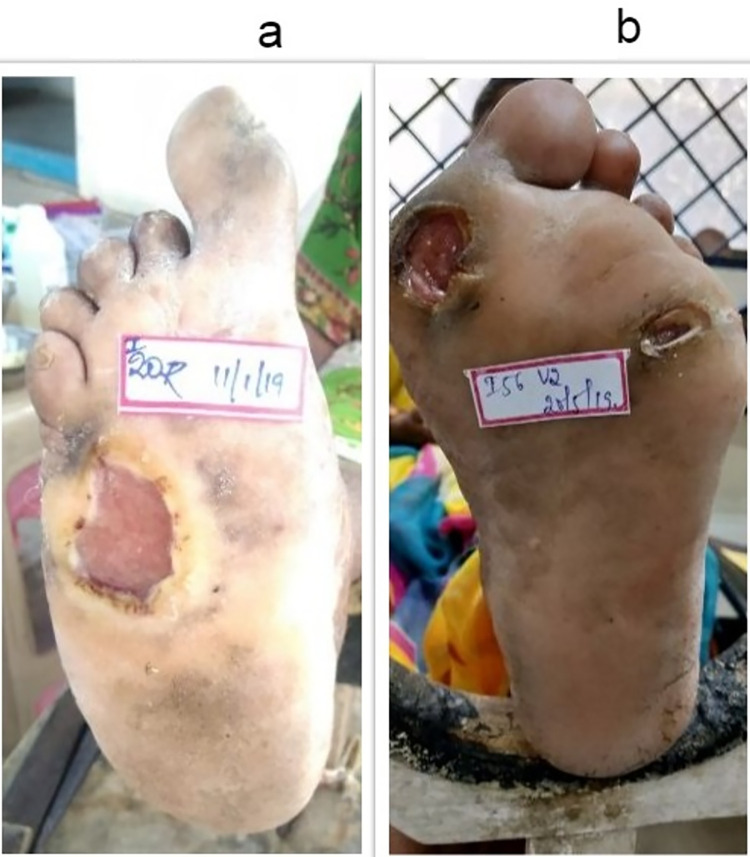
Image showing single (Fig 1a) and multiple ulcers (Fig 1b) belonging to NPUAP stage III.